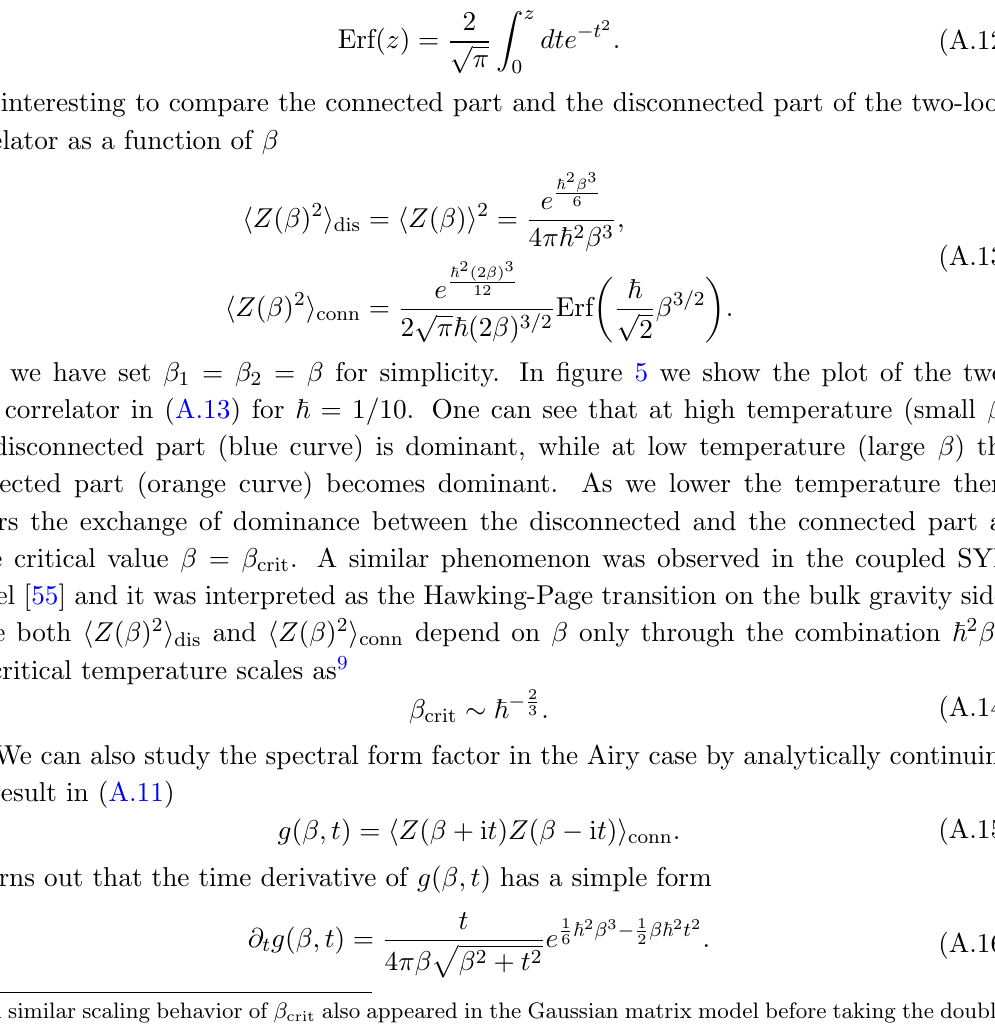
Figure 5 . Plot of two-loop correlator in the Airy case for ~ = 1 = 10. The blue curve represents the disconnected part h Z ( (cid:12) ) 2 i dis while the orange curve represents the connected part h Z ( (cid:12) ) 2 i conn . where Erf( z ) denotes the error